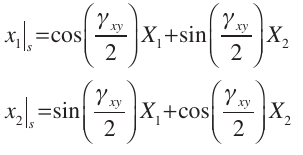
For combined extension and shear deformation, the cur- rent RVE corner locations are derived by fi rst substituting the undeformed corner locations X The undeformed RVE corner points and assumed numbering convention are shown in Figure 7 . This substitution yields the